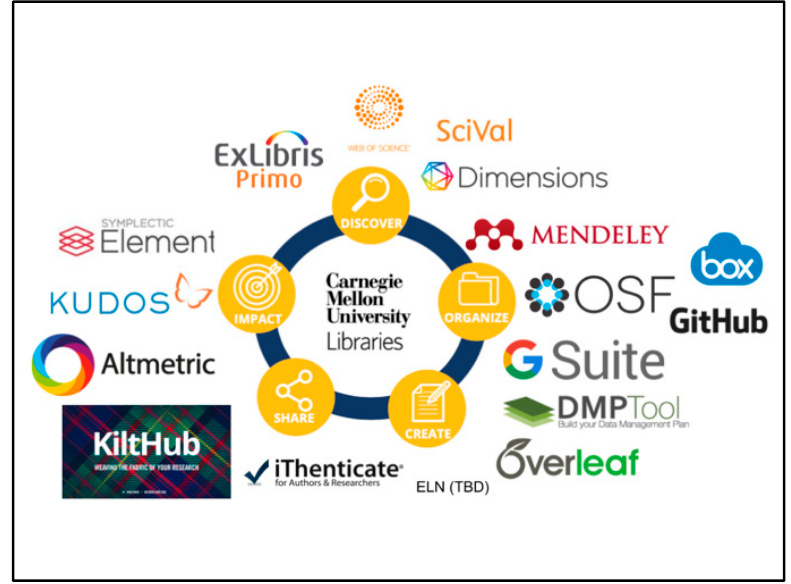
Figure 3 . The scholarly communication ecosystem at CMU. Figure 3. The scholarly communication ecosystem at